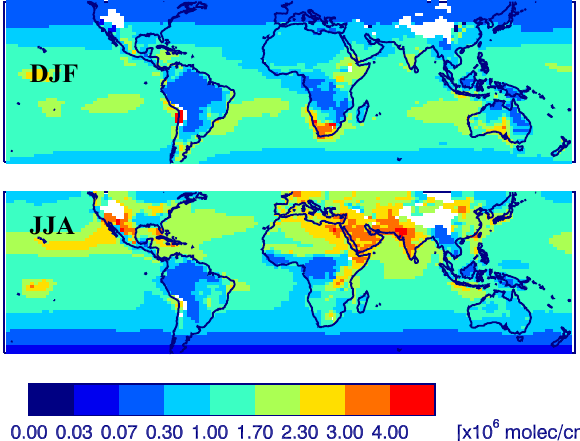
Figure 3. Seasonal mean (1988–2007) OH ( × 10 6 moleculescm − 3 ) for the Base scenario for December–February (DJF) and June– August (JJA) at